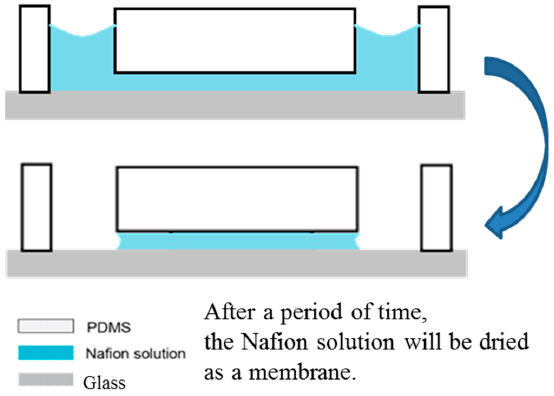
Figure 1. Fabrication of the Nafion ion-selective membrane in the microchannel.